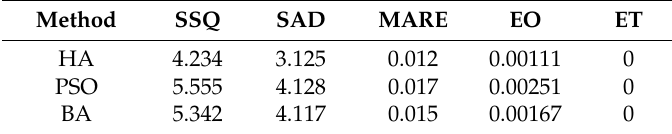
Table 5. Comparison of results based on four-parameter Muskingum model for Wilson